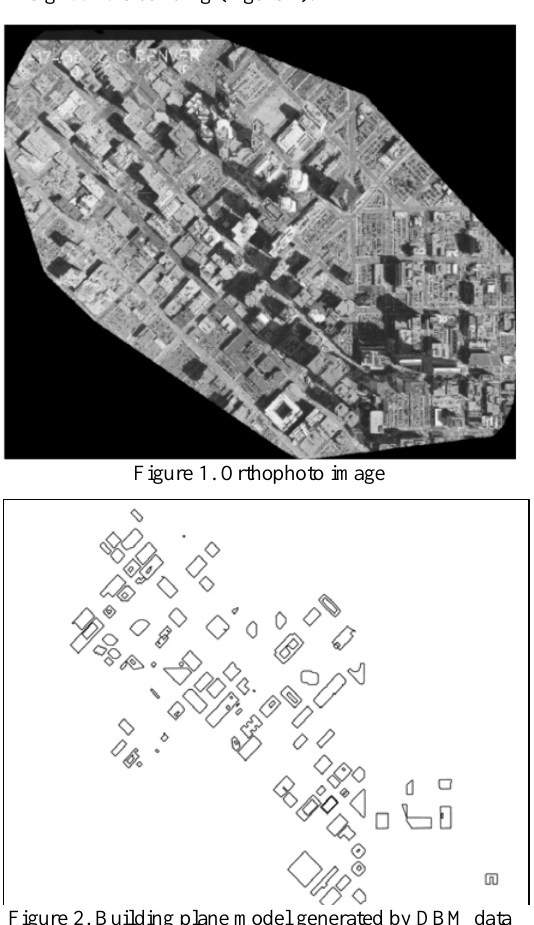
Figure 2. Building plane model generated by DBM data